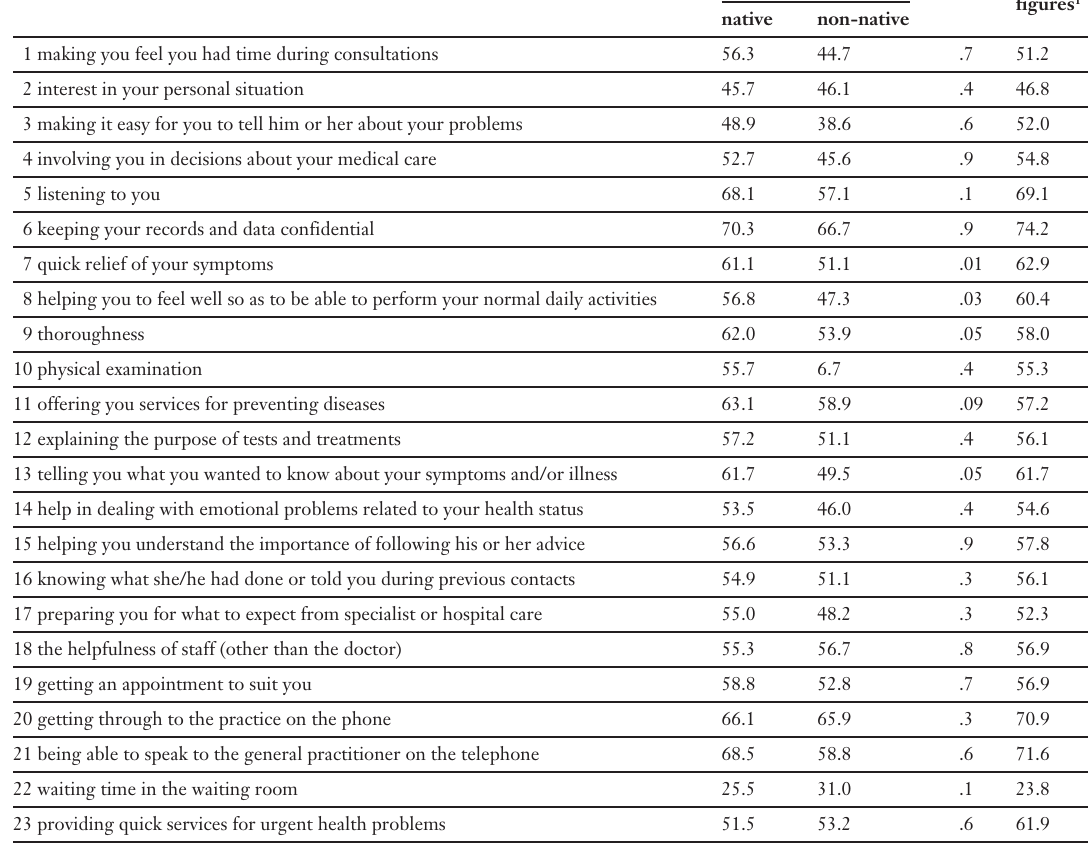
Table 1 Percentages of responders to the items of the ques- tionnaire, who marked the answer with 5 points on 5 point Likert